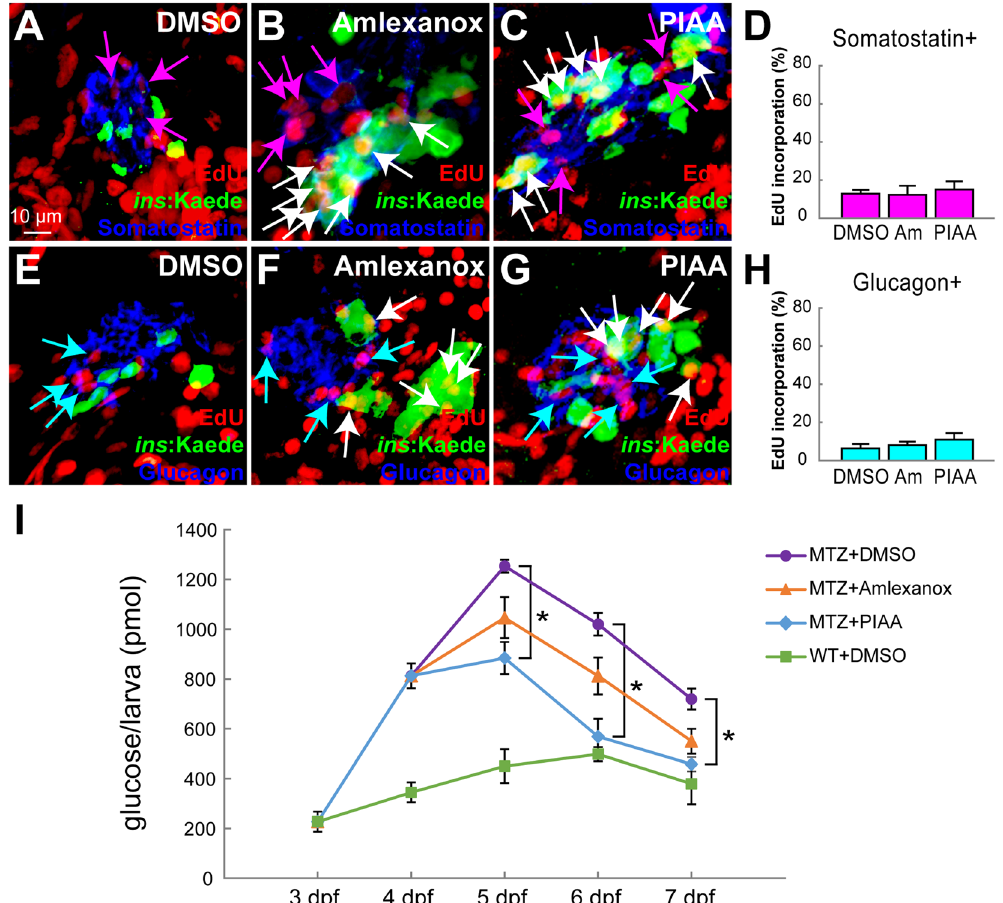
Figure 5. TBK1/IKK ε inhibitors accelerate restoration of β -cell function by selectively increasing the number of β -cells. ( A – C ) Confocal images of [ Tg ( ins : CFP-NTR ) s892 ; Tg ( ins : Kaede ) jh6 ] larvae at 48 hpa, concurrently treated with EdU and DMSO ( A ), amlexanox ( B ), or PIAA ( C ), respectively, from 0–48 hpa, stained for Somatostatin (blue). The number of Somatostatin-expressing δ -cells that incorporated EdU (purple arrows) did not increase in TBK1/IKK ε -I-treated recovering larvae ( B , C ) compared to DMSO-treated larvae ( A ). ( D ) The percentage (mean ± SD) of δ -cells that incorporated EdU at 48 hpa (in A-C; 12.9 ± 2.0% (DMSO), 12.4 ± 4.7% (amlexanox), and 15.1 ± 4.3% (PIAA)). Cells in 20 planes of confocal images from 10 individual larvae were counted per condition. ( E – G ) Confocal images of [ Tg ( ins : CFP-NTR ) s892 ; Tg ( ins : Kaede ) jh6 ] larvae at 48 hpa, concurrently treated with EdU and DMSO ( E ), amlexanox ( F ), or PIAA ( G ), respectively, from 0–48 hpa, stained for Glucagon (blue). The number of Glucagon-expressing α -cells that incorporated EdU (blue arrows) did not increase in TBK1/IKK ε -I-treated recovering larvae ( F , G ) compared to DMSO-treated larvae ( E ). ( H ) The percentage (mean ± SD) of α -cells that incorporated EdU at 48 hpa (in E-G; 6.2 ± 2.4% (DMSO), 8.0 ± 1.9% (amlexanox), and 10.9 ± 3.4% (PIAA)). Cells in 20 planes of confocal images from 10 individual larvae were counted per condition. ( I ) Free-glucose levels (mean ± SD) during β -cell regeneration in non- ablated wild type, DMSO-treated recovering, and TBK1/IKK ε -I-treated recovering larvae. At 7 dpf (equivalent to 72 hpa), free-glucose levels were significantly lower in PIAA-treated recovering larvae (blue line, 457.7 ± 28.8 pmol/larva) than in DMSO-treated larvae (purple line, 719.3 ± 42.2 pmol/larva). * P < 0.05. n = 30 larvae (3 pools of 10 larvae) per data